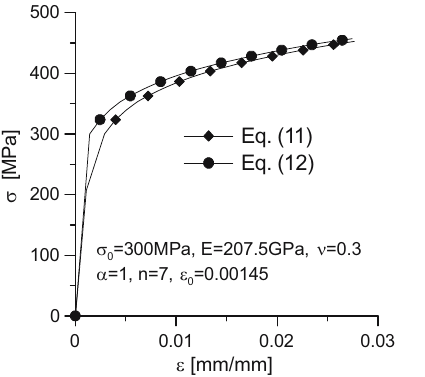
Figure 3: Model stress – strain curves based on formulas ( 11 ) and ( 12 ) ( based on ref. [ 19 ]) .